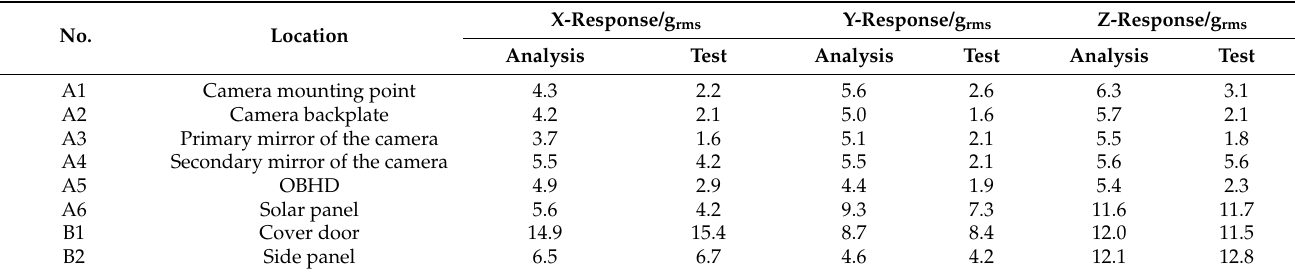
Table 9. Results of random vibration test.